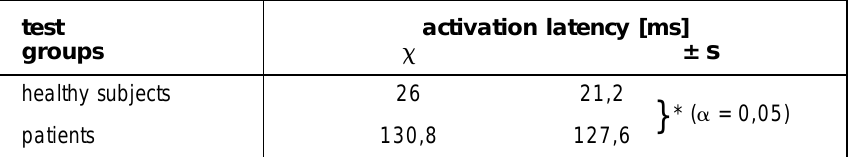
Table 4: Mean activation latencies in abduction of the